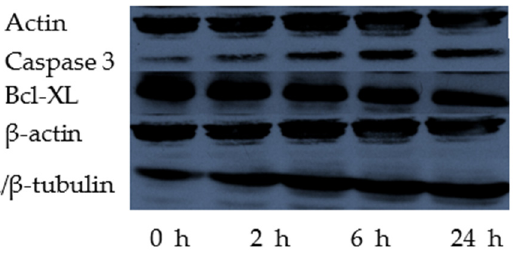
Figure 6. Effect of compound 8 on protein expression in PC3 cells (relative to β -actin).